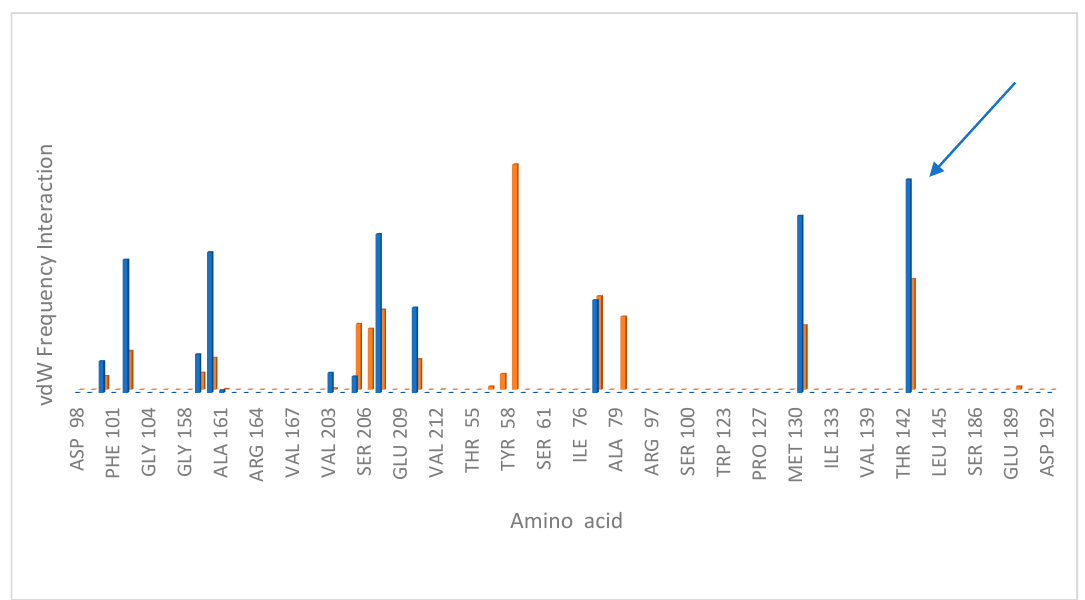
Figure 4. Frequency contacts of Van der Waals interaction measured during the dynamic simula- tion of the ligand–receptor complex; compound 18 (agonist), blue column, compound 19 (antago- nist), orange column. The molecular dynamic simulation of the protein–ligand complex was realized on a portion of protein identified by amino acids located at a distance < 2.0 nM from the center of the ‘ benzodiazepine binding site ’ . During the simulation, the selected fragment did not show excessive distortion, as evidenced by Ramachandran ’ s plot [12] (Figure 5), which is relative to the complex conformation at the end of the 60 ns of simulation: only 9% of amino acid residues are located in a disallowed region (white).